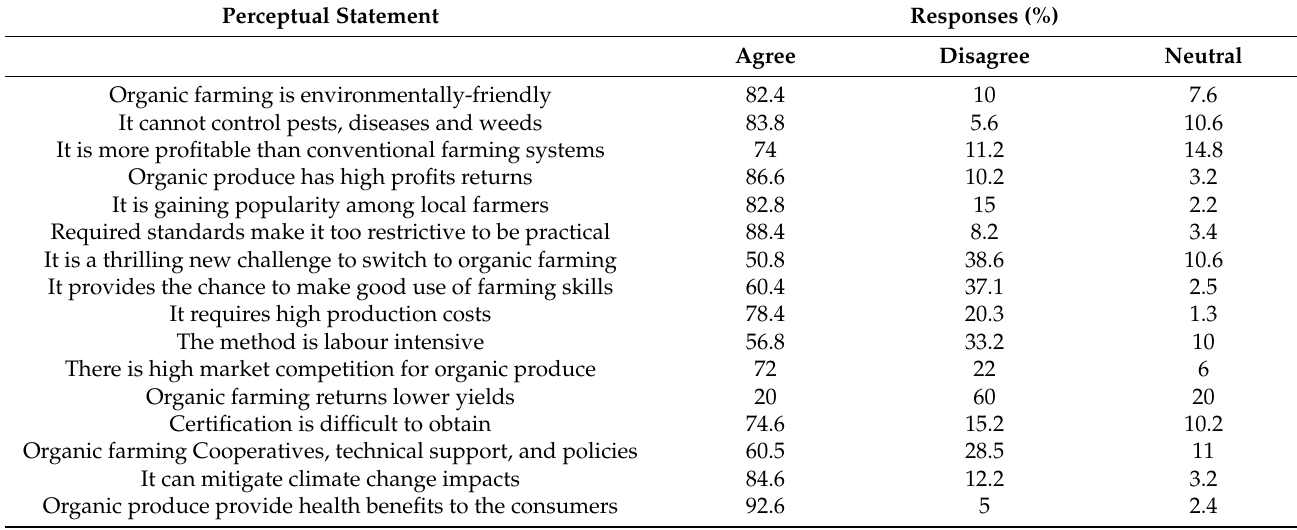
Table 2. Distribution of perceptual statement of organic farming.